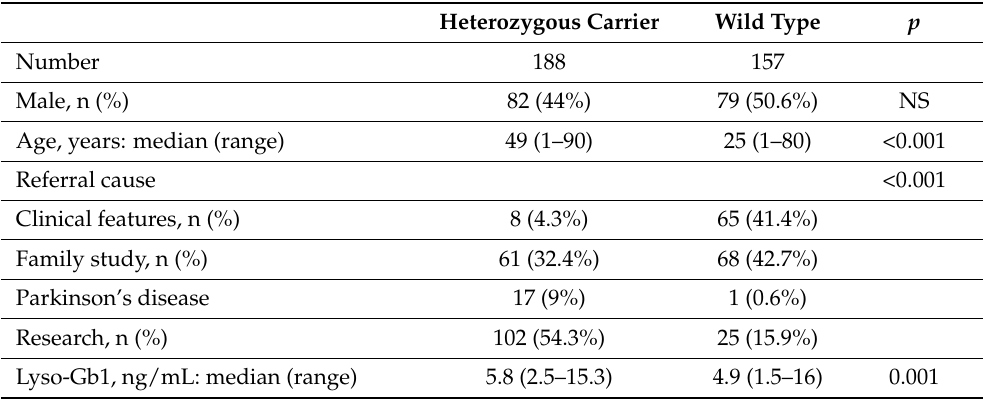
Table 4. Characteristics of carriers vs. those with wild type GBA1